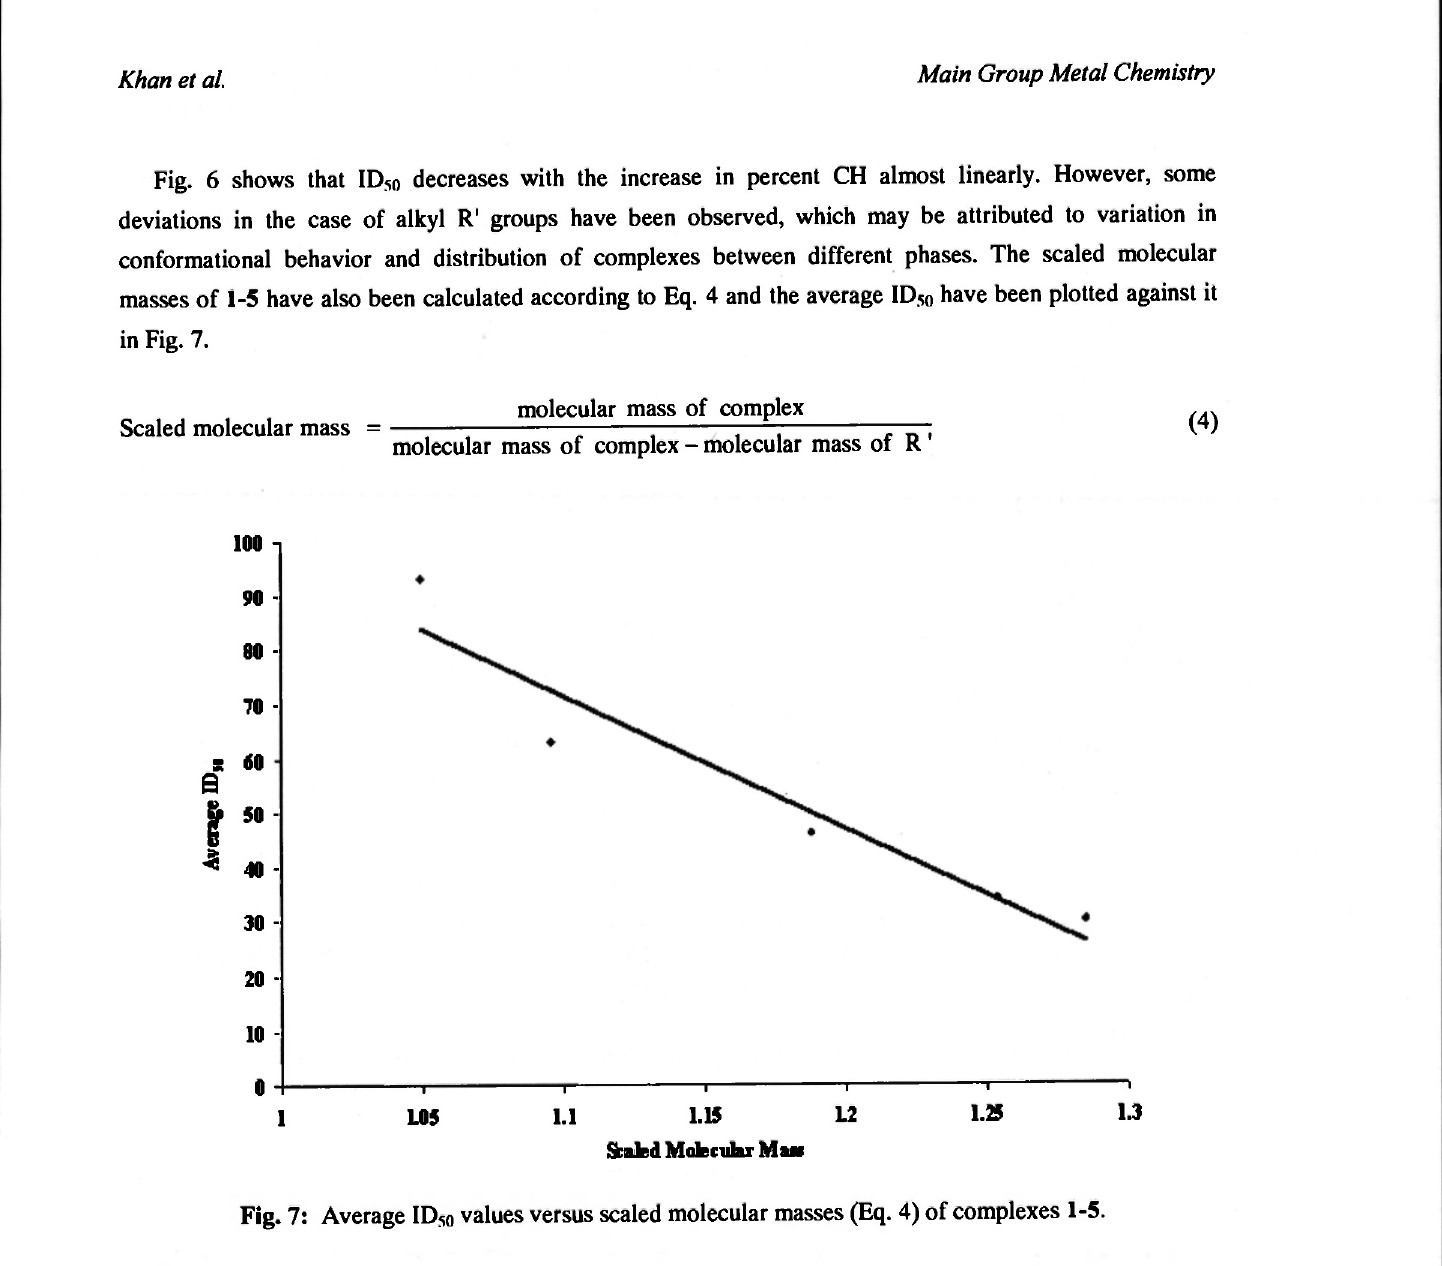
Fig. 7: Average ID S0 values versus scaled molecular masses (Eq. 4) of complexes